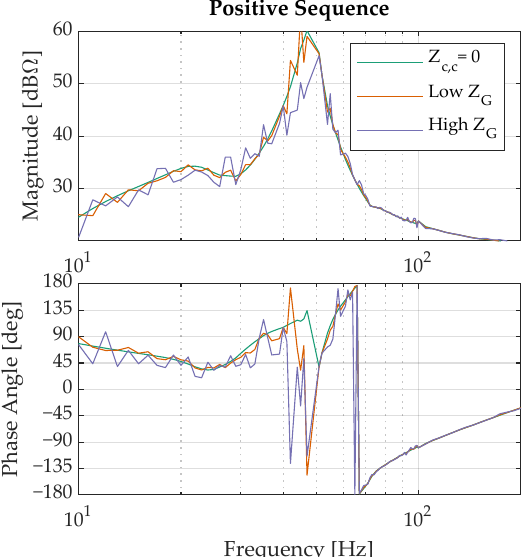
Figure 18. MMC TB impedance with no coupling modeled ( Z c , c = 0), high SCR (low Z G ) and low SCR (high Z G